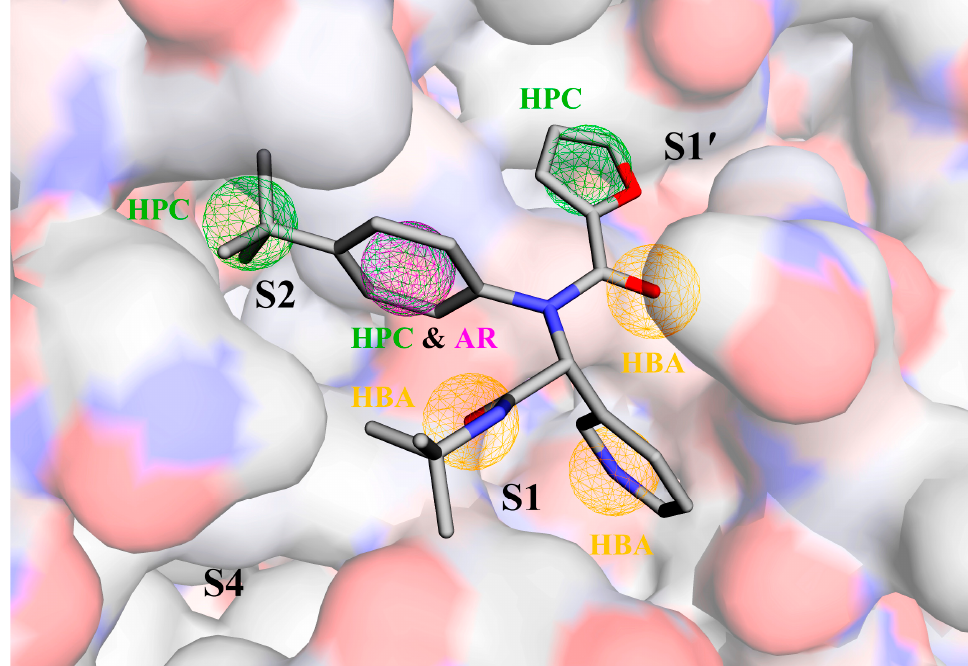
Figure 2. The pharmacophore model generated by the Pharmit server in the substrate-binding cavity of the SARS-CoV-2 Mpro (PDB ID: 7L0D [34] ). Mpro and ML188 are shown as surface and stick representations, respectively, with the red, blue, and gray regions/atoms corresponding to O, N, and C atoms, respectively. Pharmacophore features are represented by mesh spheres with the following color codes: orange for the hydrogen bond acceptor (HBA), green for the hydrophobic center (HPC), and purple for the aromatic ring (AR).